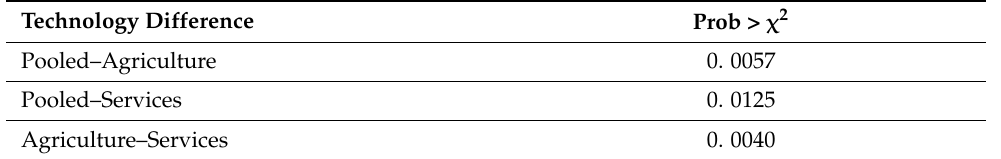
Figure 7. ROC curves and C-statistic estimates for the sectoral models (firms). Table 18. Wald test results for the pooled and sectoral subsample models